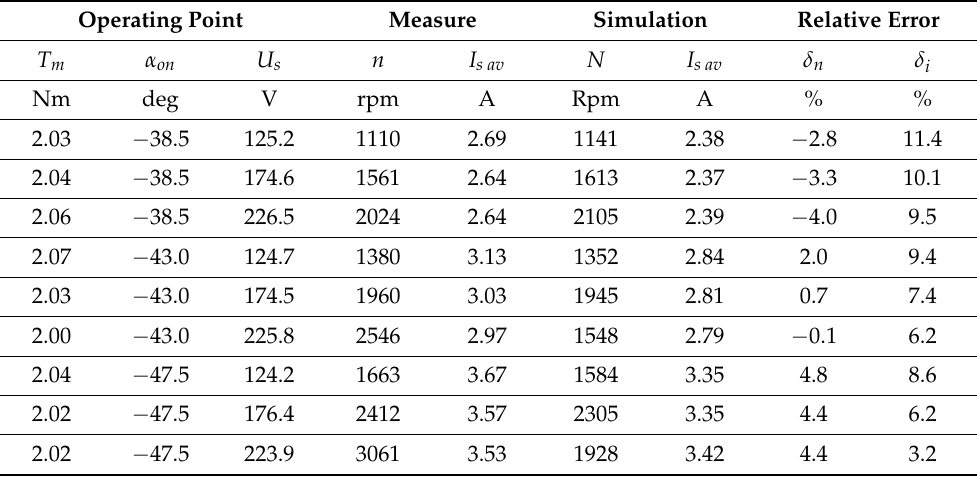
Table 3. Measurement verifications of calculation results for various values of supply voltage.